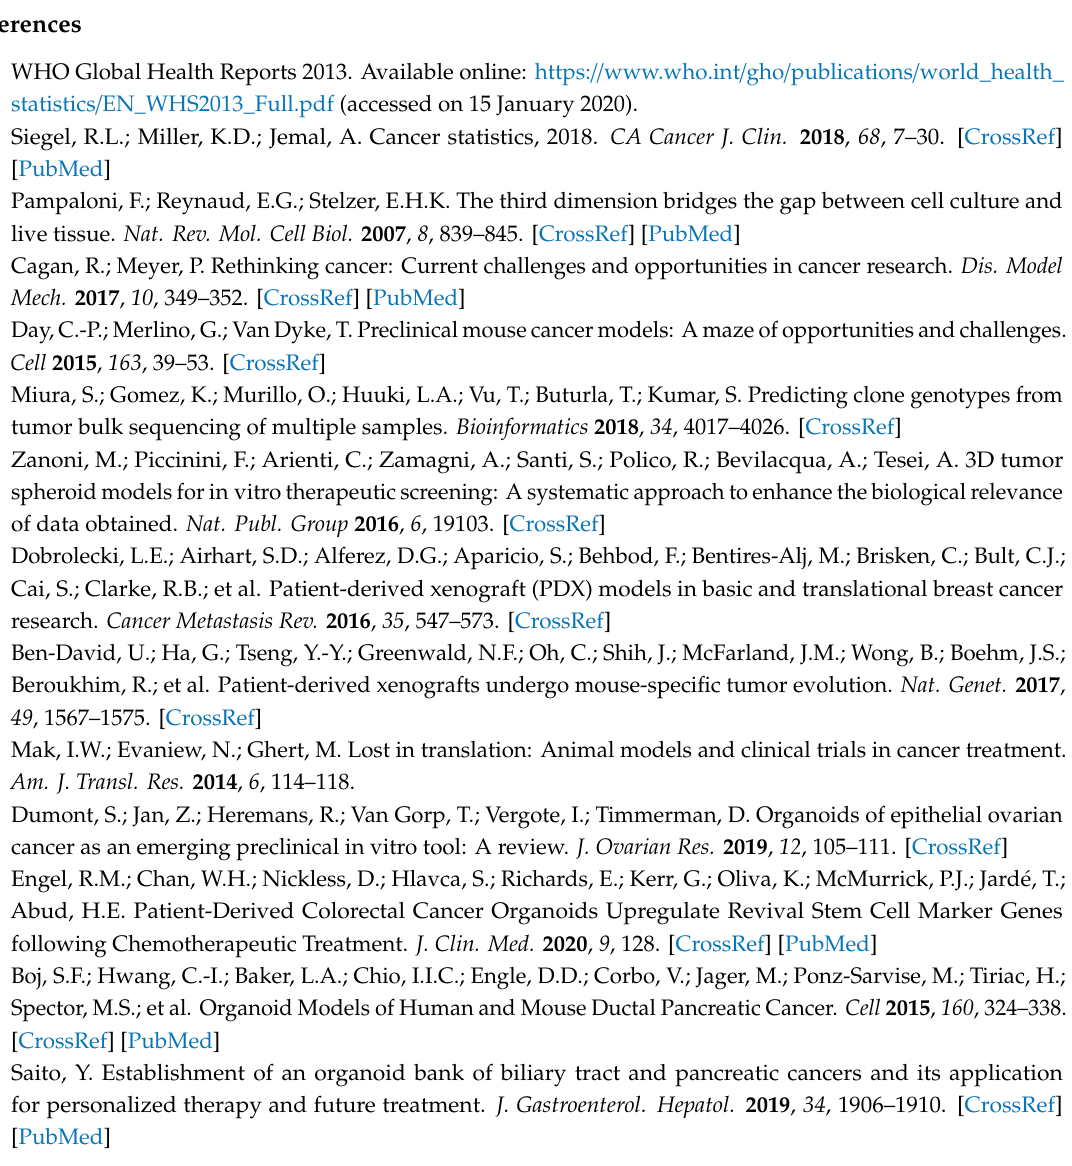
Figure S1: Purification of 4T1-BFP + cells from BALB / c and NSG tumors; Figure S2: Network visualization of enriched pathways, Figure S3: Heat maps of key cancer pathways, Figure S4: Dot blot of genes used to identify cell clusters, Figure S5: Cancer cell expansion in ex vivo